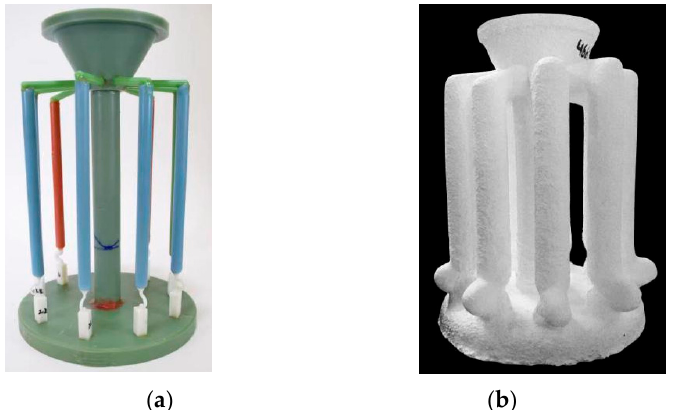
Figure 2. Images of the wax model ( a ) and the shell mold ( b ).